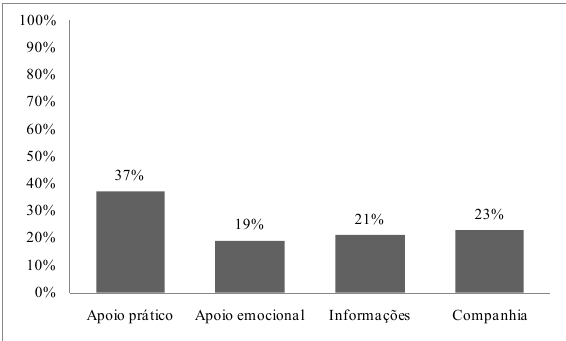
Figura 2 . Porcentagem de cada tipo de apoio recebido pelas